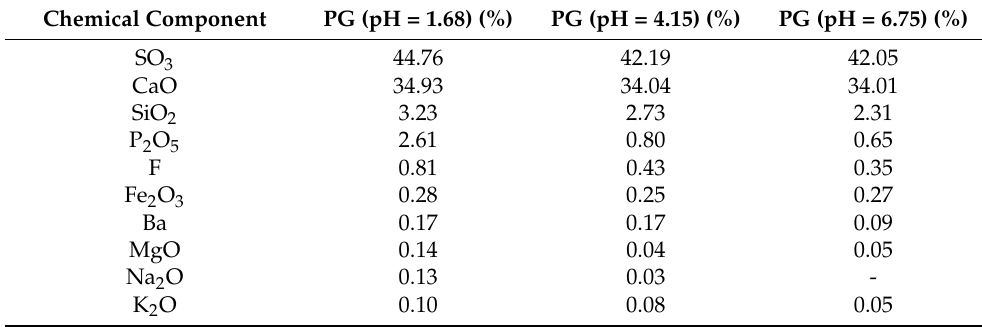
Table 2. Main chemical components of the three batches of PG.